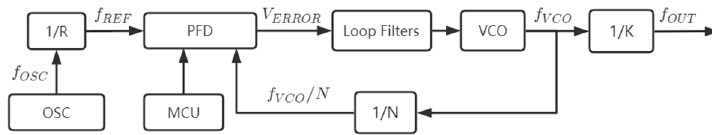
Figure 2. Frequency synthesizer system architecture.